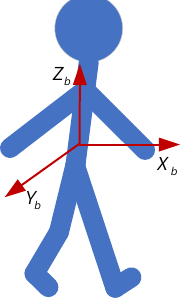
Figure 2. The walking components of pedestrian movement.